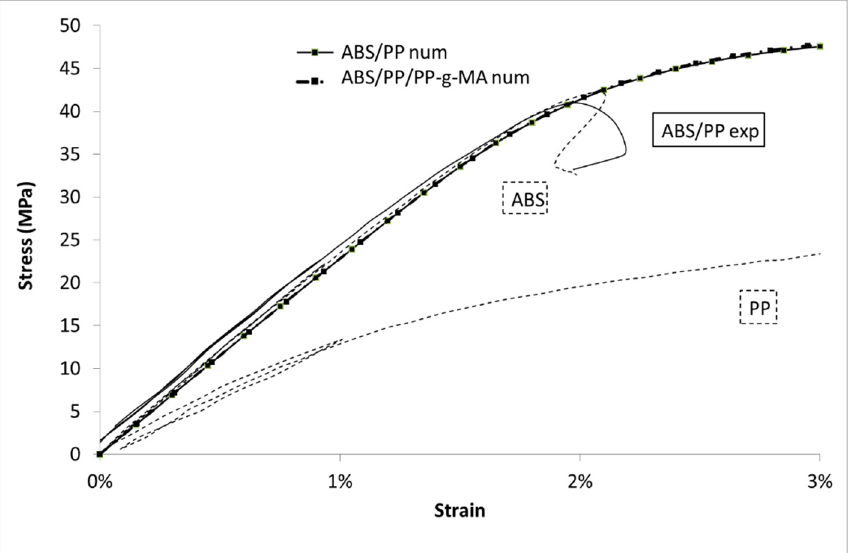
Figure 17. Stress vs. Lagrangian strain for ABS/PP and ABS/PP/PP-g-MA composites, experiments and modelling.